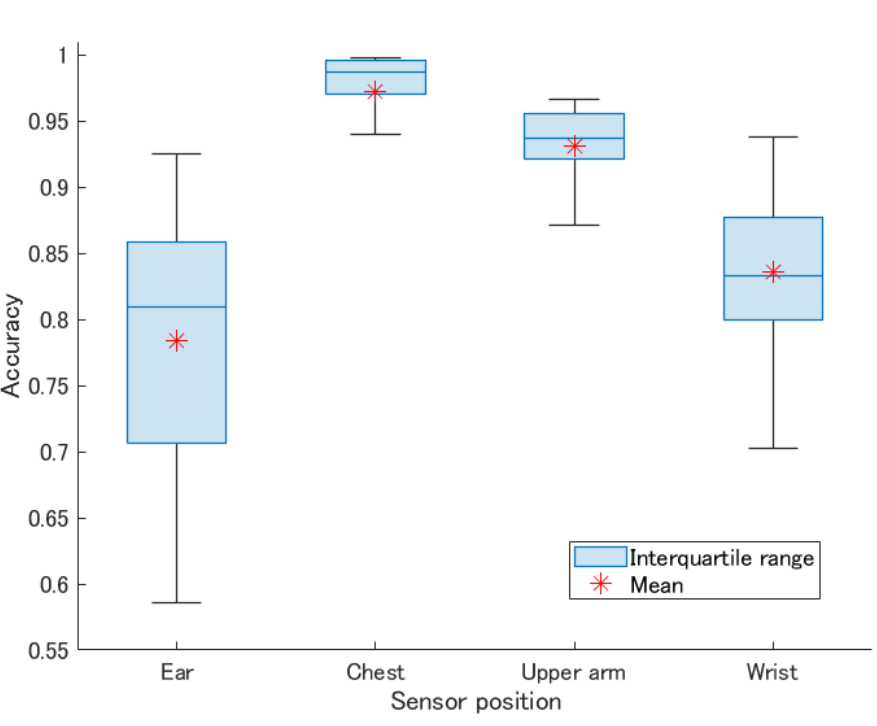
Figure 9. Box plot of the accuracy of each random validation ( n = 50). Table 8. Maximum and minimum classification accuracy of 50 random template exercise Table 7. P-values of accuracy between two positions